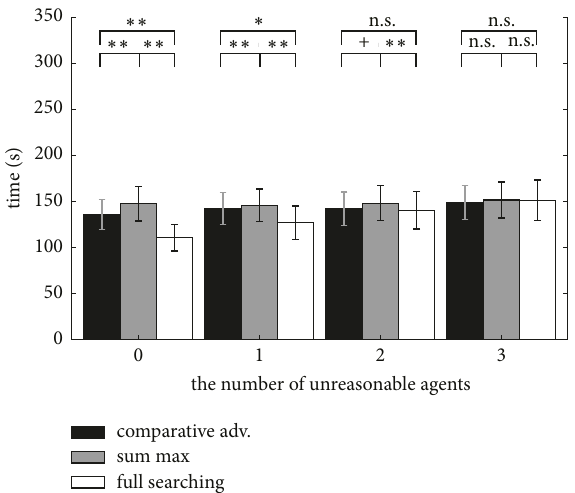
Figure 27: Makespan in situations where there is an unreasonable agent (four robots). ∗∗ 𝑝 < .01 , ∗ 𝑝 < .05 , and + 𝑝 < .1 . A significant 𝑝 value indicates that a significant difference in prescribing exists between the conditions. The lower 𝑝 value indicates a strong significant difference. n.s. means no significant difference between the conditions. Table 12: Moving ability of each robot. Proceeding Rotating Roomba